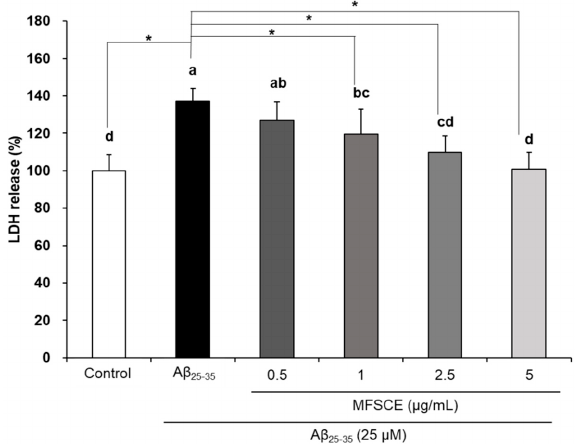
Figure 2. Effect of membrane-free stem cell extract (MFSCE) on lactate dehydrogenase release activity in SH-SY5Y cells treated with A β 25–35 . Values are presented as mean ± SD ( n = 6). The different letters (a–d) among groups represent significant differences determined by ANOVA and Duncan’s multiple range test (p < 0.05). Asterisk (*) indicates significant differences using Mann–Whitney U-test (p < 0.05).